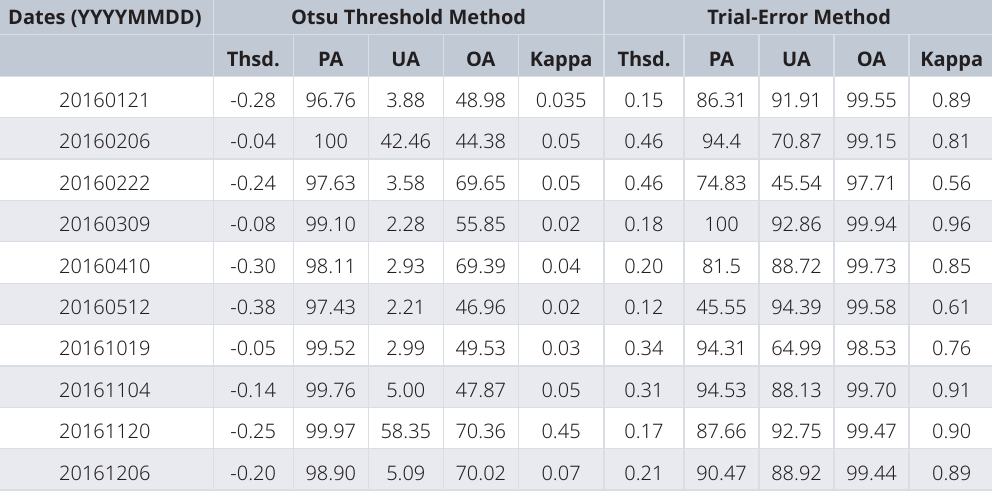
Table 2. Accuracy assessment for Otsu method and trial and error threshold method for extraction of surface water bodies. Dates